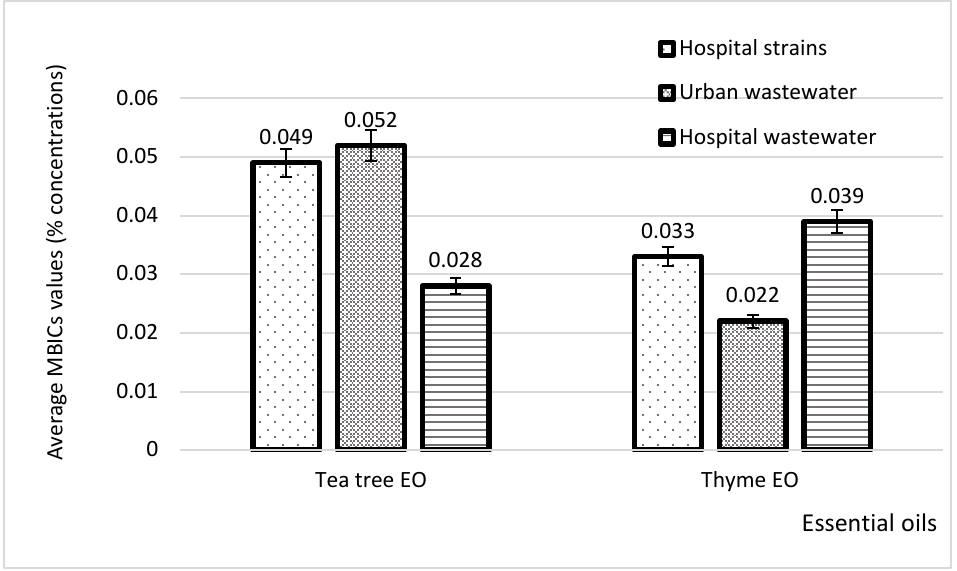
Figure 8. The average MIC values of P. aeruginosa strains depending on their isolation source (MICs are expressed as percentage (%) oil in the culturing media).